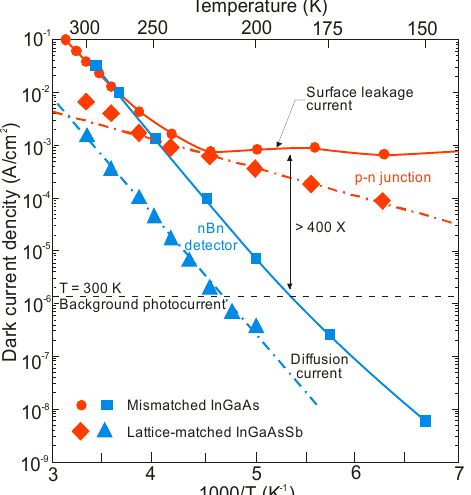
Figure 65. Arrhenius plots for both InGaAs and InGaAsSb p-n junctions and nBn detectors with λ cut-off =2.8 μ m (adapted after [195]).